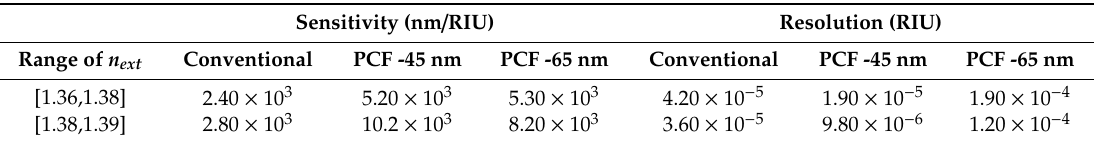
Table 1. Sensitivity and resolution values for both